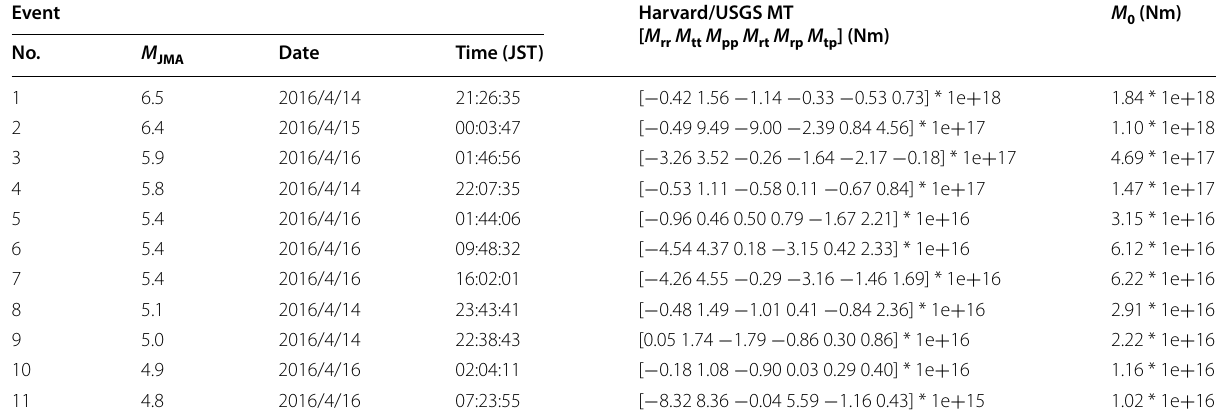
Table 4 MT elements of the inferred solutions for Kumamoto earthquakes in Harvard/USGS form Event